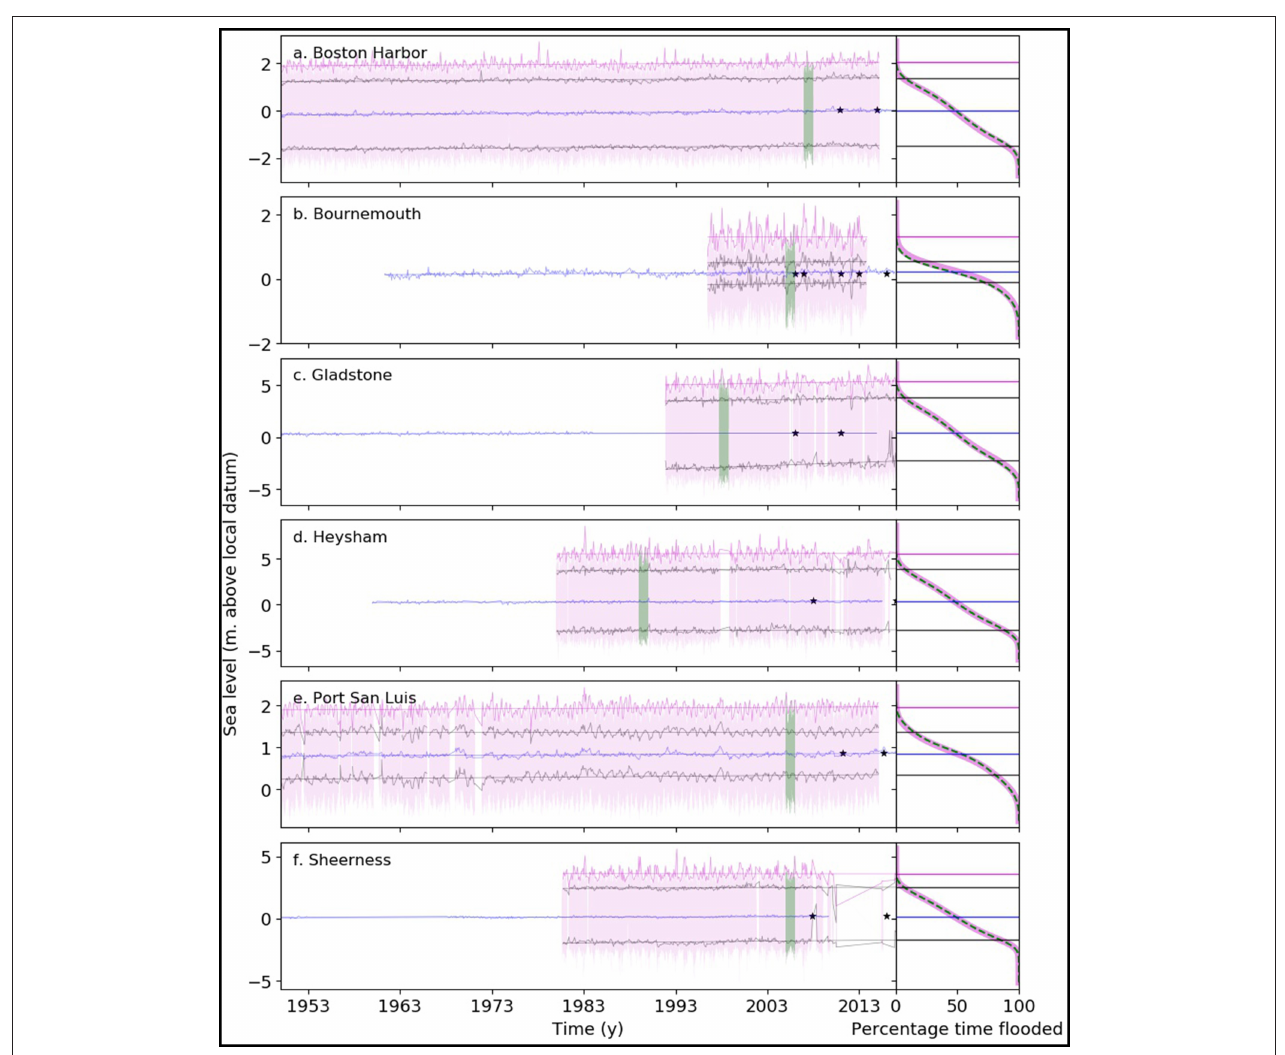
FIGURE 4 | left: Hourly sea level record (pink) and monthly Mean Sea Level MSL (blue) for each station between 1950 and 2017. Black lines are, respectively, the monthly Mean High Tide MHT and Mean Low TIde MLT . Thicker pink lines are monthly Observed Highest High Tide OHHT . Straight lines are monthly linear trends for each metric. Green areas represent the most recent complete year of record. Right: Cumulative distribution function of flooded time for a given elevation for the whole tidal record (pink), and for the chosen representative year (dashed green). Horizontal lines are the most recent value of the linear monthly trends. (a–f) Tide gauges neighboring the examined marshes. Black stars indicate the dates of lidar